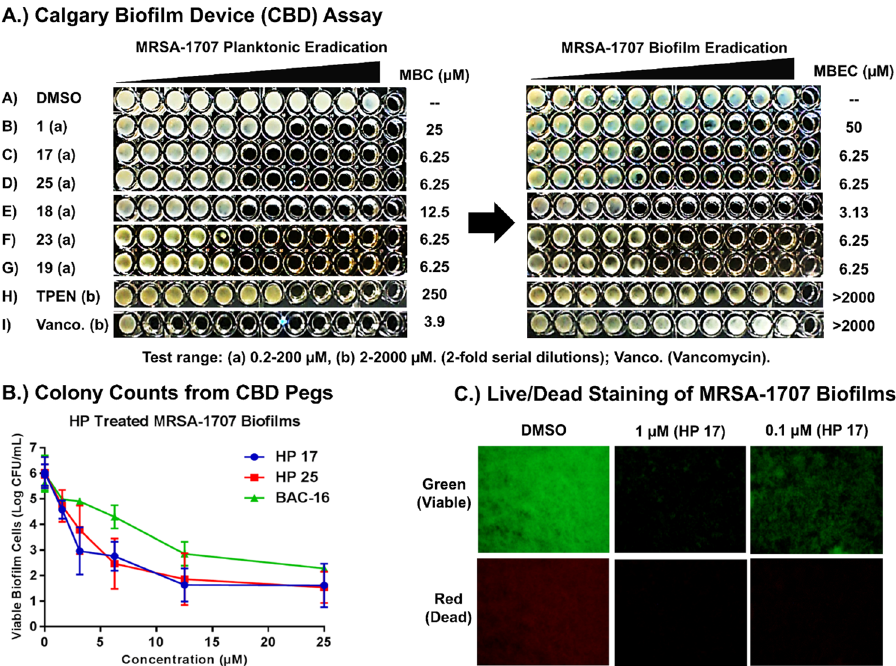
Figure 7. ( A ) Calgary biofilm device (CBD) assay of a panel of HPs, TPEN and vancomycin against MRSA- 1707 demonstrating the potent and unique biofilm eradication activities of HP small molecules. ( B ) Dose- response curve of biofilm eradication for HP 17 (MBEC = 4.69 µ M), HP 25 (MBEC = 9.38 µ M) and BAC-16 (MBEC = 25 µ M) against MRSA-1707 (pulse treatment). ( C ) Live/Dead staining (fluorescence images) of established MRSA-1707 biofilms treated with HP 17 after 24